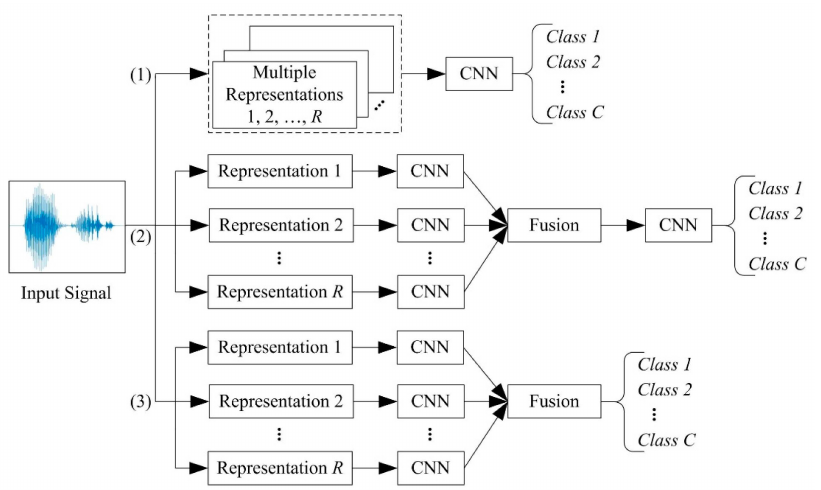
Figure 2. Overview of fusion techniques for learning from multiple representations of the same signal: (1) early-fusion, (2) mid-fusion, and (3)